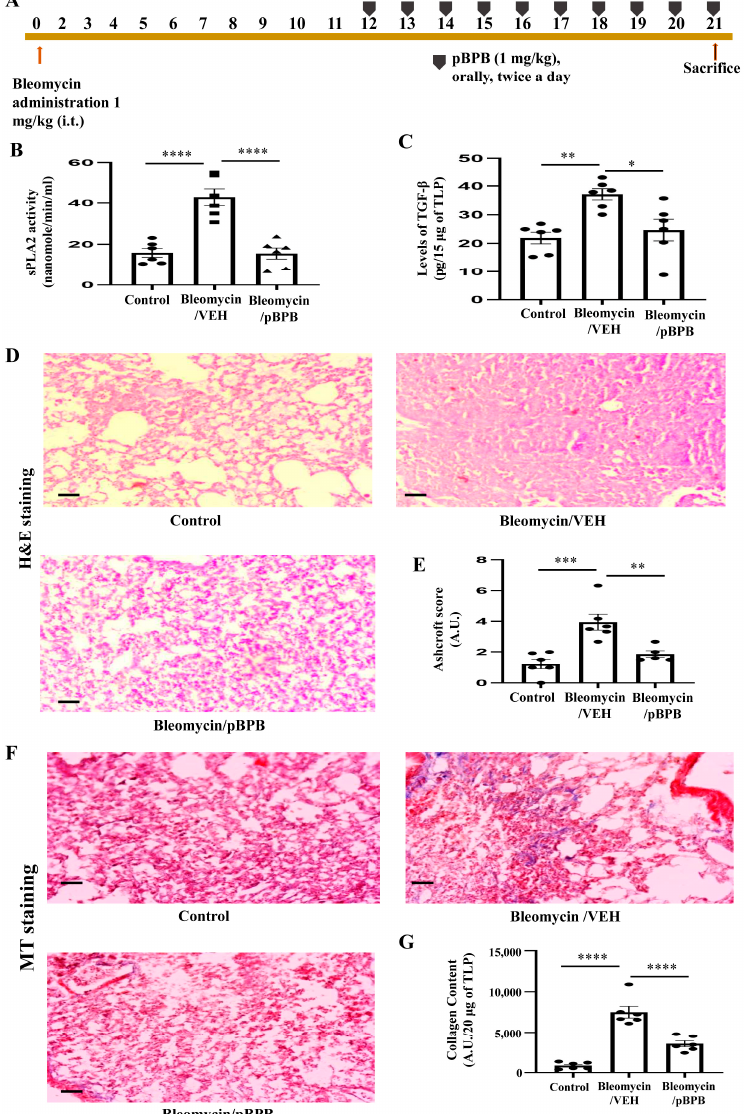
Figure 8. pBPB ameliorates pulmonary fibrosis in Bleomycin-treated mice ( A ) Schematic showing the mice experimental plan, mice were treated with bleomycin (orotracheal instillation) and from day 12 onwards, pBPB was given orally; twice a day and after euthanasia, mice were sacrificed on day 21. There were three groups and n = 6 in each group. ( B ) sPLA2 activity and ( C ) TGF- β 1 ELISA was performed in mice sera samples and total lung lysates of bleomycin-treated mice, respectively, **** p = 0.0001 for control versus Bleomycin/VEH group and **** p = 0.0001 for Bleomycin/VEH versus Bleomycin/pBPB group, and ** p = 0.003 for control versus Bleomycin/VEH group, * p = 0.014 for Bleomycin/VEH versus Bleomycin/pBPB group,sPLA2 activity and TGF- β 1, respectively. ( D ) and ( E ) H and E staining (bars = 100 µ m) revealed attenuation in pulmonary inflammation in Bleomycin/pBPB treated mice, Ashcroft score. *** p = 0.0004 for control versus Bleomycin/VEH group and ** p = 0.0056 for Bleomycin/VEH versus Bleomycin/pBPB group ( F ) and ( G ) MT staining (bars = 100 µ m) results has shown reduced collagen deposition in lungs of Bleomycin/pBPB treated mice as compared to Bleomycin/VEH mice, semi-quantitative morphometry to assess collagen deposition in lungs. n = 6. **** p = 0.0001 for control versus Bleomycin/VEH group and **** p = 0.0001 for Bleomycin/VEH versus Bleomycin/pBPB